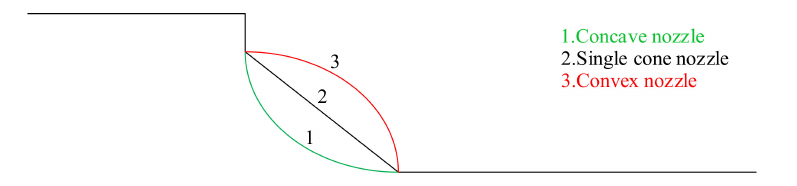
Figure 6. The curves of the contraction section.